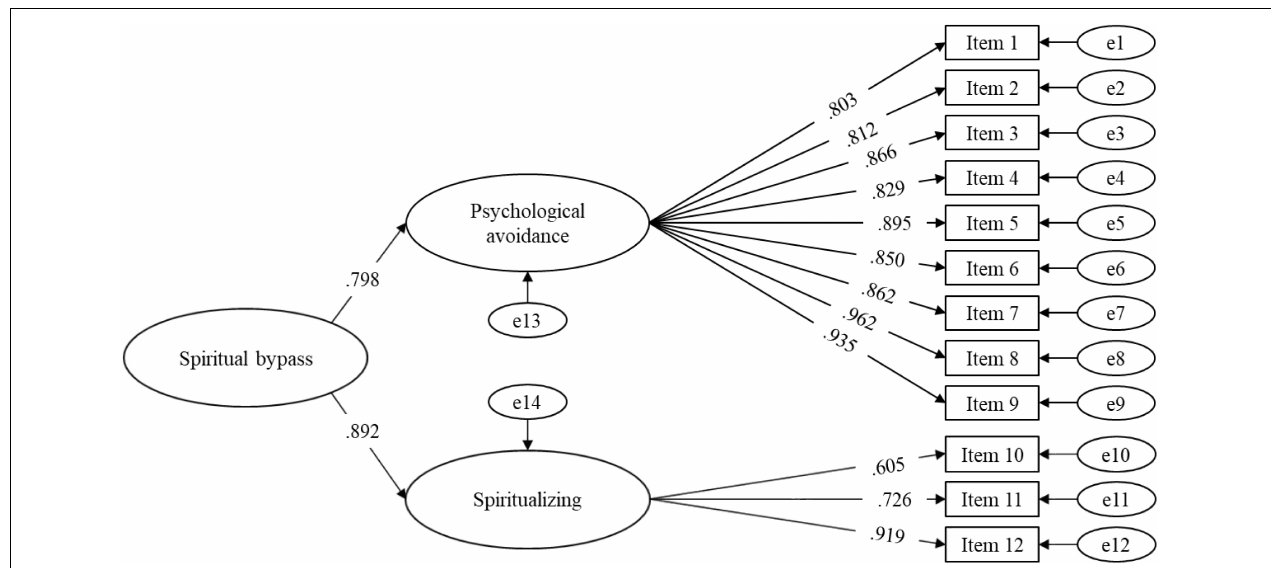
FIGURE 1 | SBS-12 factor structure. Model of second-order factor. Standardized coefficients. All factor loadings are statistically significant ( p s < 0.001), N = 435.